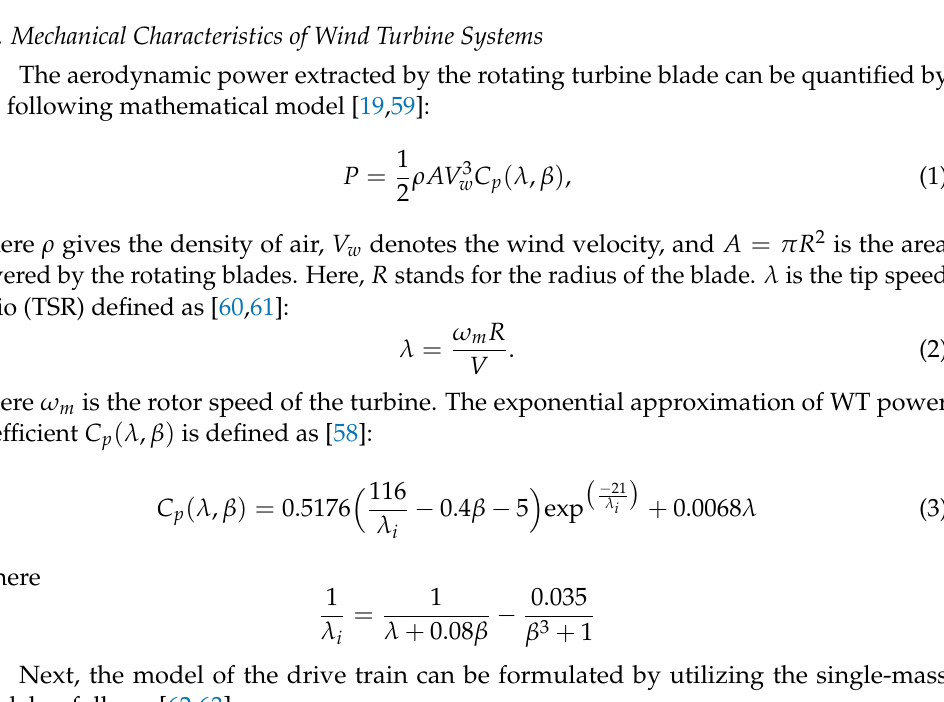
Figure 1. Schematic representation of PMSG-based